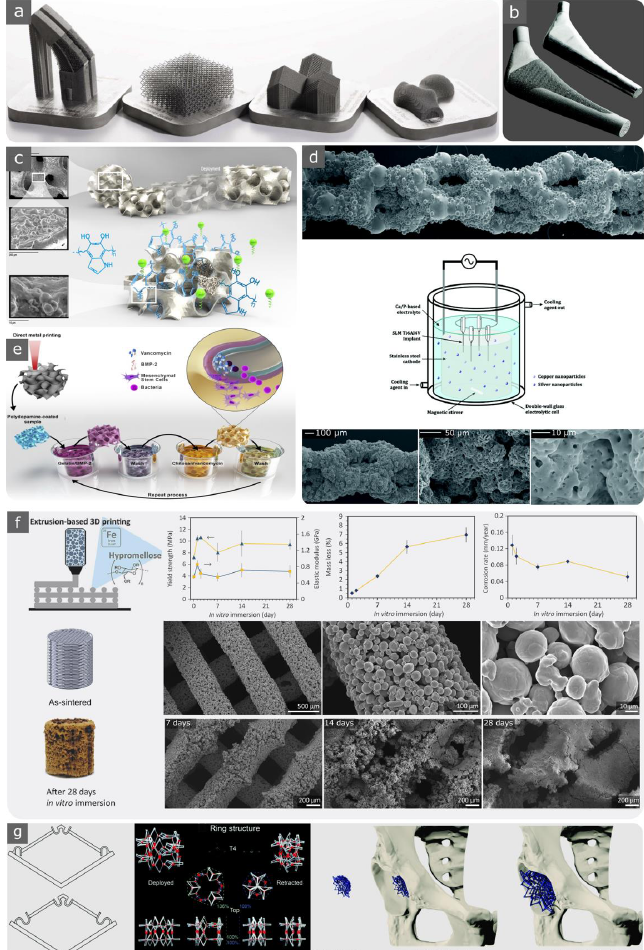
Figure 2. ( a ) Examples of porous metallic structures and bio-implants with various functionalities (reprinted from Ref. [92] with permission, Copyright 2022 Elsevier); ( b ) a hybrid implant that com- bines solid and porous parts in a single device (reproduced from Ref. [25] with permission from the Royal Society of Chemistry); ( c – e ) biofunctionalisation of AM products; ( c ) surface biofunction- alisation of a porous Nitinol structure using polydopamine-immobilised rhBMP-2 (reprinted with permission from [137], Copyright 2022 American Chemical society); ( d ) self-defending additively manufactured implants bearing silver and copper nanoparticles; ( top ) scanning electron microscope (SEM) imaging was used to image the surface morphology of a selective laser melted Ti–6Al–4V implant, ( middle ) a schematic drawing of the electrolytic employed for plasma electrolytic oxidation (PEO) bio-functionalization process, and ( bottom ) SEM images showing the surface morphology after PEO biofunctionalisation at different magnifications (reproduced from Ref. [138] with permission from the Royal Society of Chemistry); ( e ) the layer-by-layer coating process for the biofunction- alisation of additively manufactured meta-biomaterials [139]; ( f ) a schematic of extrusion-based 3D printing process for the fabrication of porous scaffolds; SEM images showing as-sintered and as-degraded iron scaffolds as well as in vitro corrosion products after 7, 14, and 28 days of im- mersion and the yield strengths, elastic moduli, mass loss percentages, and corrosion rates of the scaffolds before and after in vitro immersion for up to 28 days [145]; ( g ) the principle of deployable implants demonstrated schematically by arranging bi-stable implants (reproduced from Ref. [128] with permission from the Royal Society of